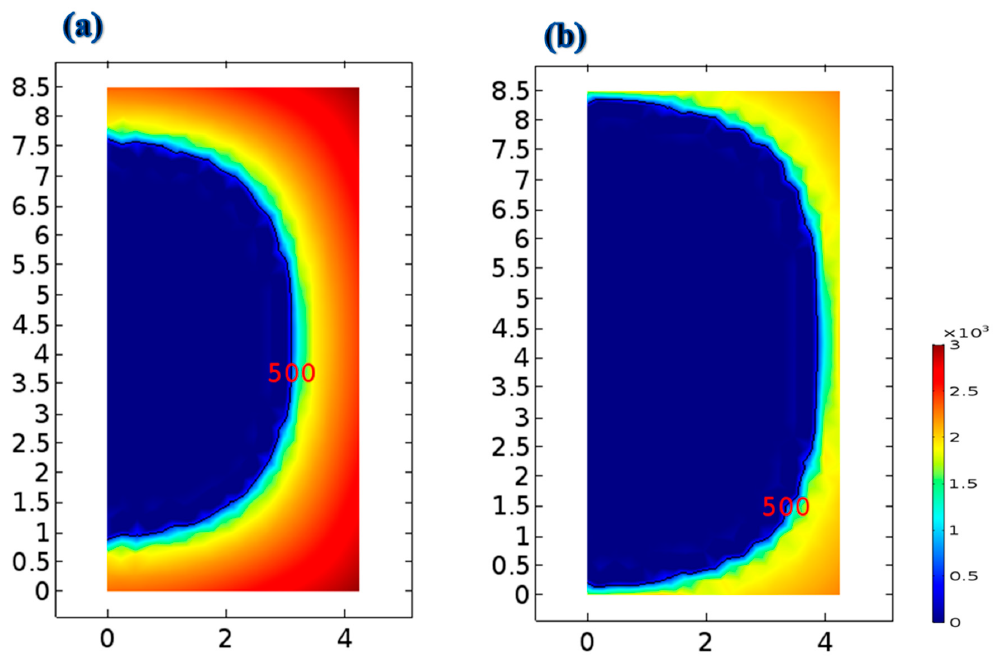
Figure 10. Distributions of acrylamide in the strip after 9 min of frying: ( a ) without the temperature-step frying approach at 170 °C and ( b ) with the temperature-step frying approach at 170 °C.